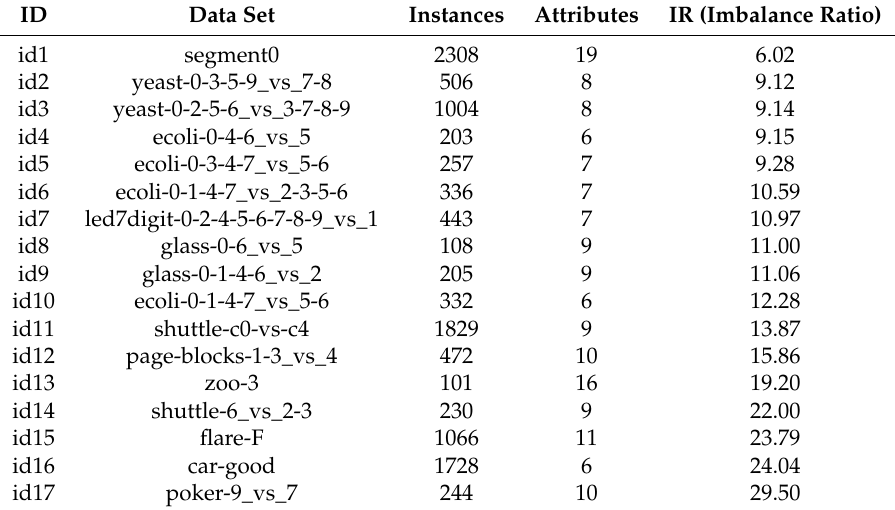
Table 2. Summary description of imbalanced data